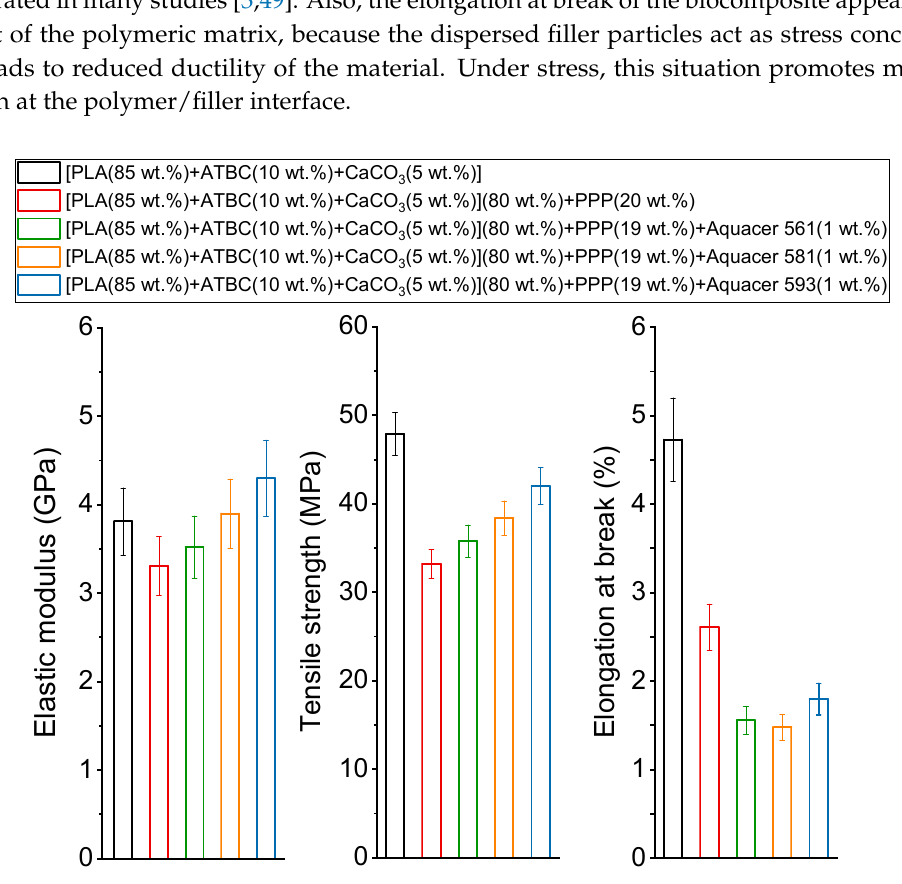
Figure 3. Elastic modulus, tensile strength and elongation at break of the PLA base matrix and biocomposites indicated in the legend.